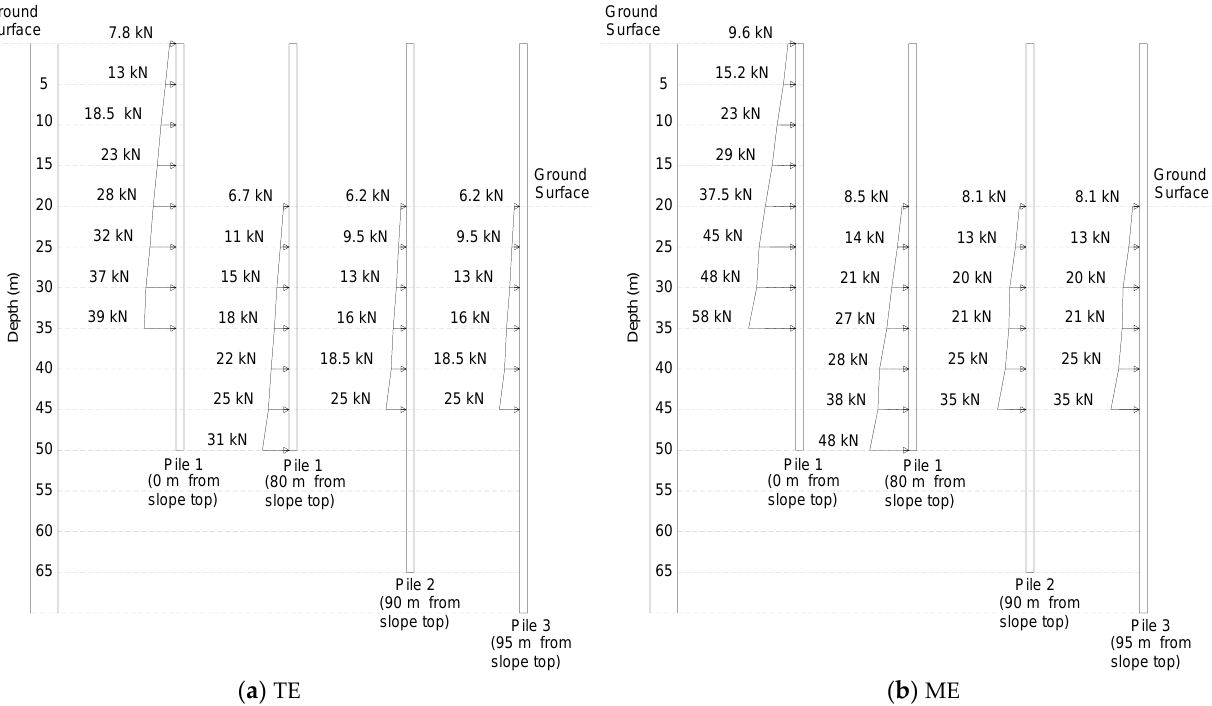
Figure 13. Examples of kinematic forces using the proposed method.